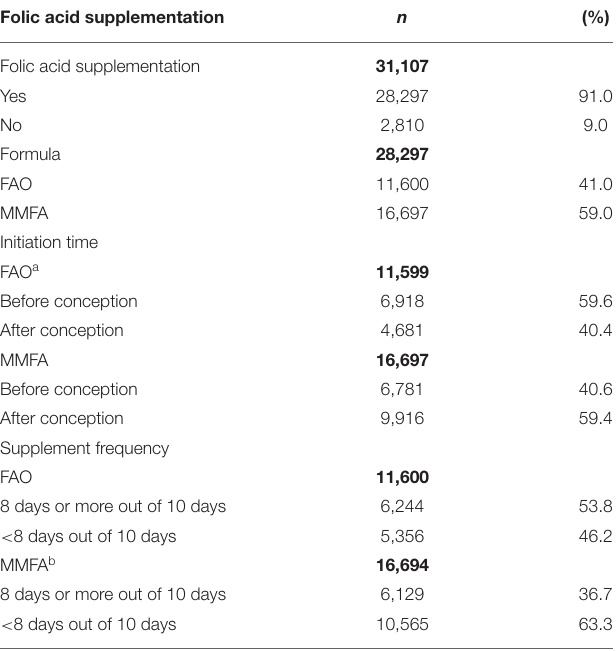
TABLE 2 | Folic acid supplementation among women who gave birth to singleton newborns at the Tongzhou Maternal and Child Health Hospital,